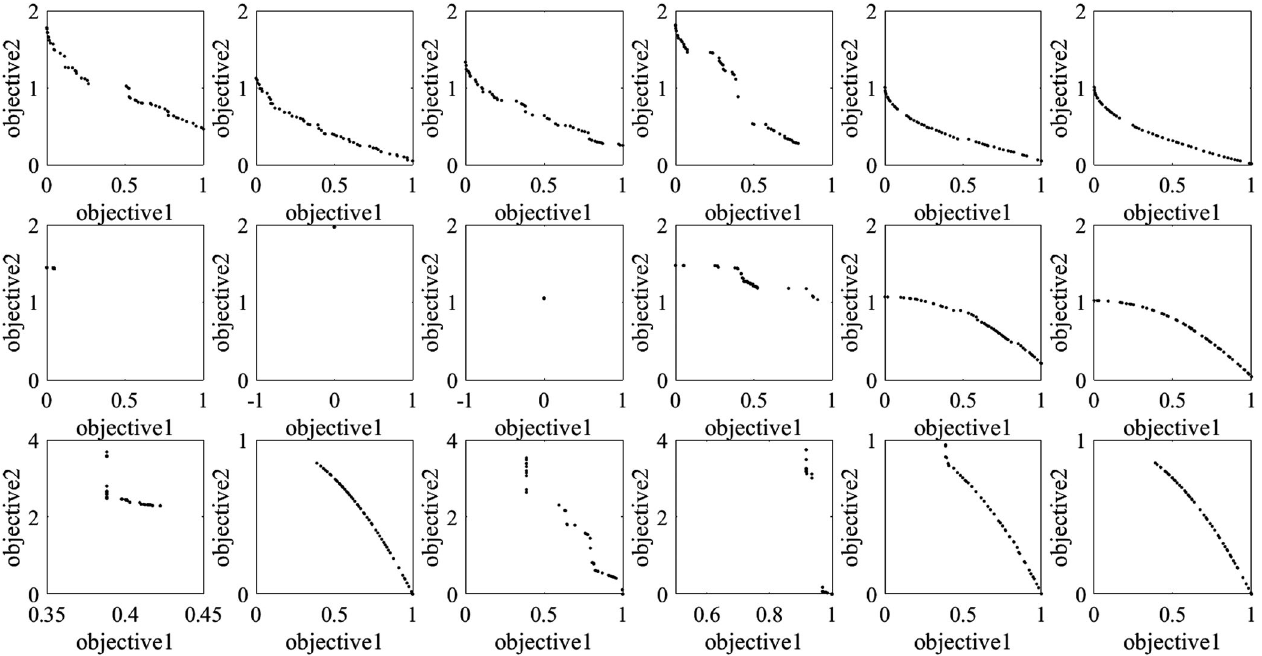
FIG. 5. Variations of the average diversity metric optimizations.